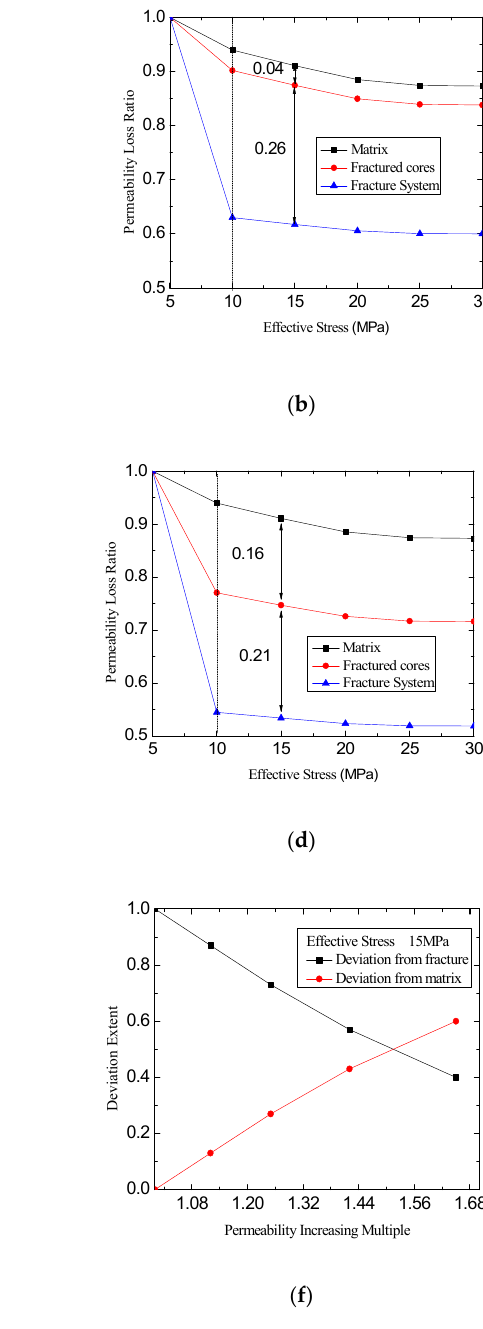
Figure 9. Sensitivity analysis results. Permeability loss ratio curves for ( a ) cores with different penetration extents, ( b ) the core with 25% penetration, ( c ) the core with 50% penetration, ( d ) the core with 75% penetration, and ( e ) the core with 100% penetration, and (f) variation curve of the deviation extent and increasing multiples.